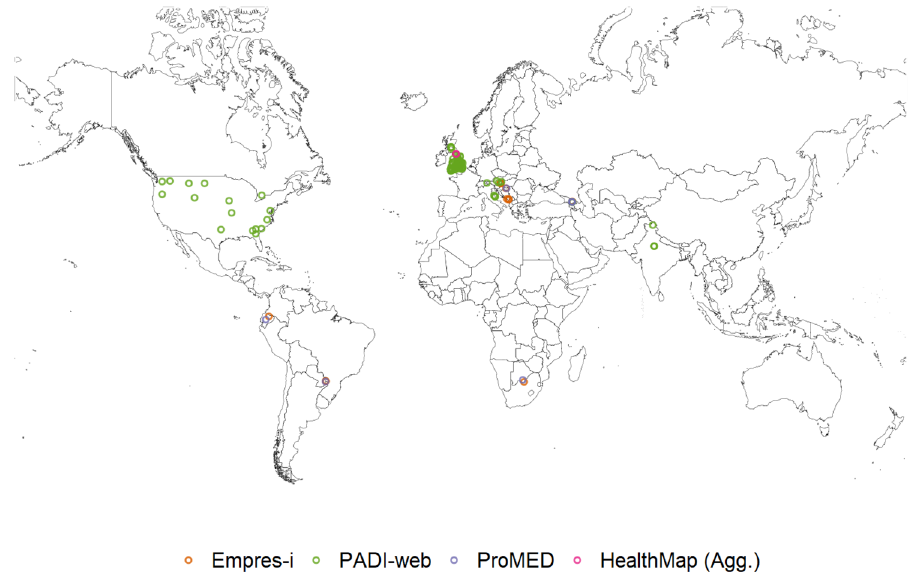
Fig 5. Bluetongue (BTV) outbreaks reported in Empres-i and BTV relevant signals detected by PADI-web, ProMED and HealthMap (Agg.) from January to June 2016. in North America, as well as malignant catarrhal fever in Europe and North America (Table 3, Fig 5).